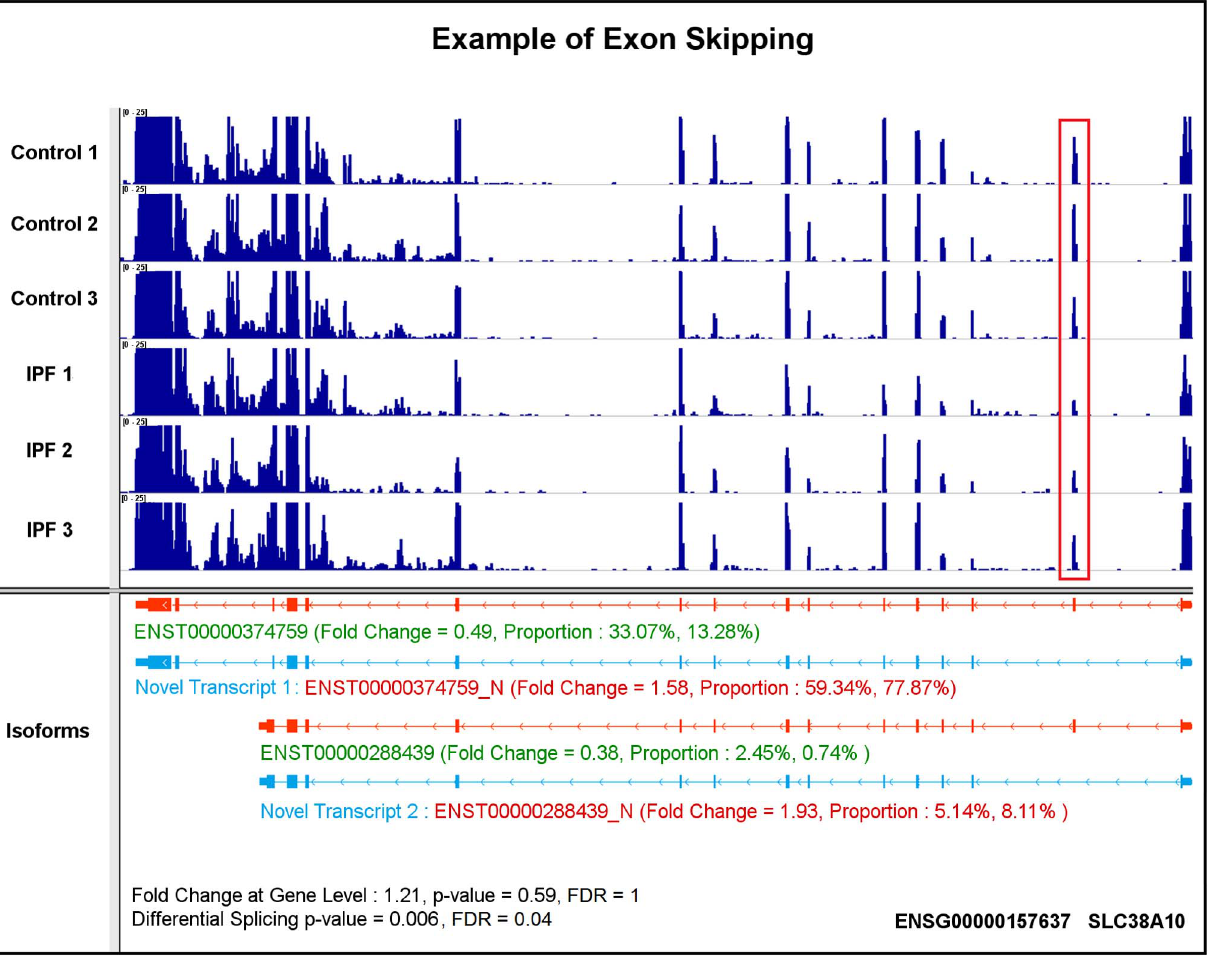
Figure 5. A case study of gene SLC38A10 illustrating the skipping exon splicing mechanism using both annotated and predicted transcripts.